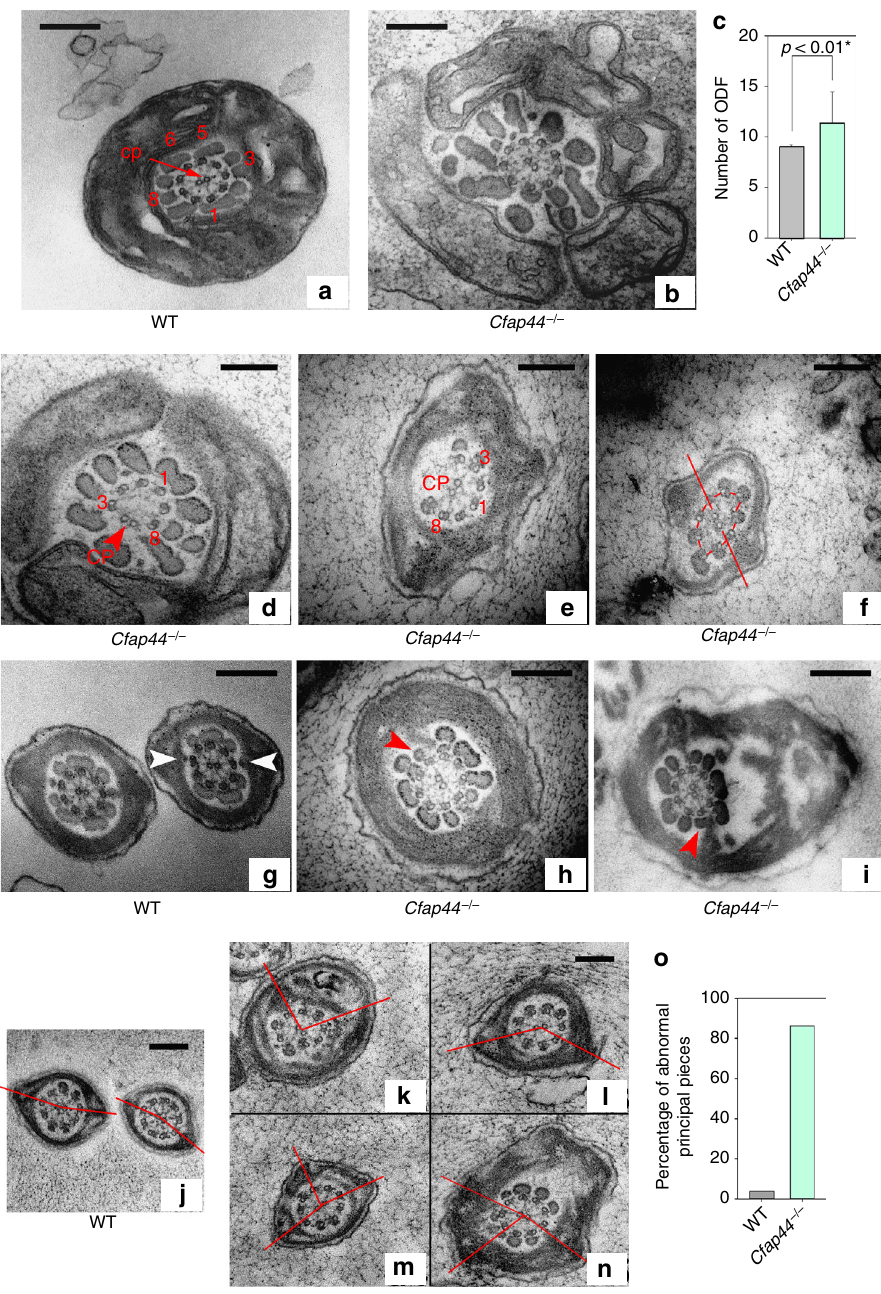
Fig. 6 Electron microscopy cross-sections of sperm from Cfap44 − / − males reveal multiple structural axonemal defects. a Cross-section of the midpiece of a WT sperm, showing the arrangement of the ODFs around the axoneme. b Presence of extra ODFs in midpieces sections of sperm from Cfap44 − / − males. The orientation of ODFs is also defective, leading to an increase of the midpiece diameter. a , b Same scale bars = 250 nm. c Graph showing the increased number of ODF in the mutant. Data represent mean ± SD; the statistical difference was assessed with t test, P value as indicated. Twenty-one cross- sections in the midpiece region were analyzed for WT and 21 for Cfap44 − / − . d – f Various structural defects of the axoneme in sperm from Cfap44 − / − males. d Four DMTs (4 – 7) were missing. The central pair is shifted at the periphery (red arrowhead). e DMTs 5 – 7 were missing. Note the presence of a third longitudinal column (LC). f Irregular distribution of the DMTs associated with a rotation of the central pair (straight red line). Scale bars = 196 nm. g In WT sperm, the fi brous sheath is linked to the 3-central-8 complex by stalks emerging from the longitudinal columns (white arrowheads). h , i The presence of extra ODFs facing DMTs 3 and 8 (red arrowheads) prevents a normal anchoring of the fi brous sheath ’ s stalks on DMTs 3 and 8. Scale bars = 270 nm. j – o LCs are not aligned with 3 – 8 CPC axis. In contrast to WT, where the 3-central-8 complex is aligned with LC to form almost a straight line ( j , red line), LC are misaligned in sperm from Cfap44 − / − males, leading to notable asymmetry of the structure ( k , m , red lines). l , n The presence of a third LC increases asymmetry. Scale bars = 184 nm. o Bar graph showing the % of defects observed in the principal piece as described in g – n . One hundred cross-sections in the principal piece region were analyzed for WT and 50 for Cfap44 − /